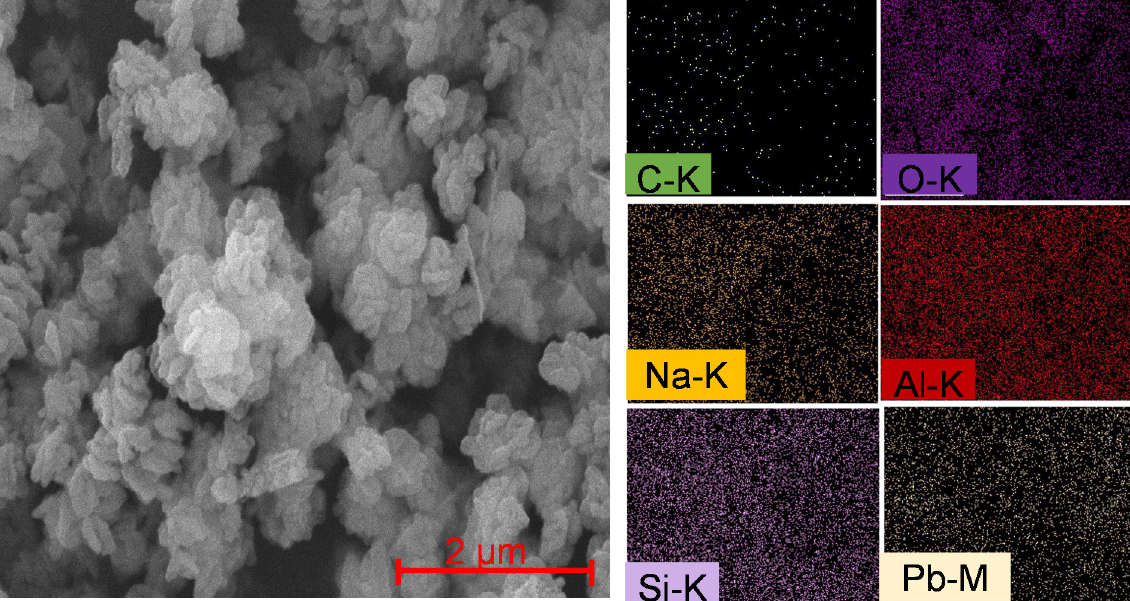
Figure 11. XRD analysis of S80H9 after Pb 2+ adsorption. FTIR analysis (Figure 12) of sodalite following the adsorption of Pb 2+ ion revealed the formation of cerussite based on the appearance of lead ion peak at 1110 cm − 1 [42], carbonate 5